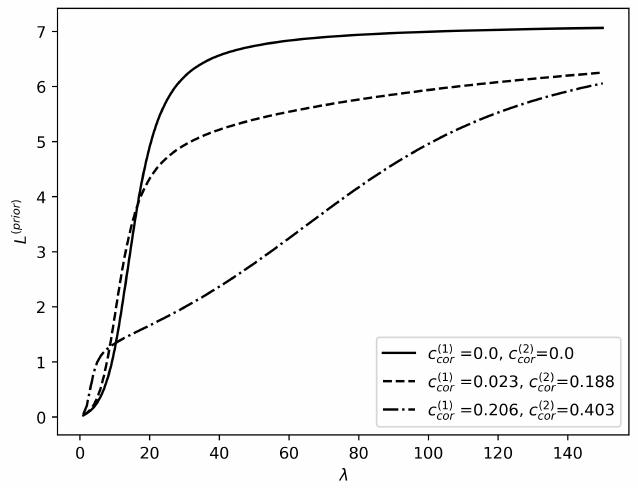
Figure 8. The mean number of priority customers in the buffer, L ( prior ) , as a function of the input rate λ for the BMMAP s with different coefficients of